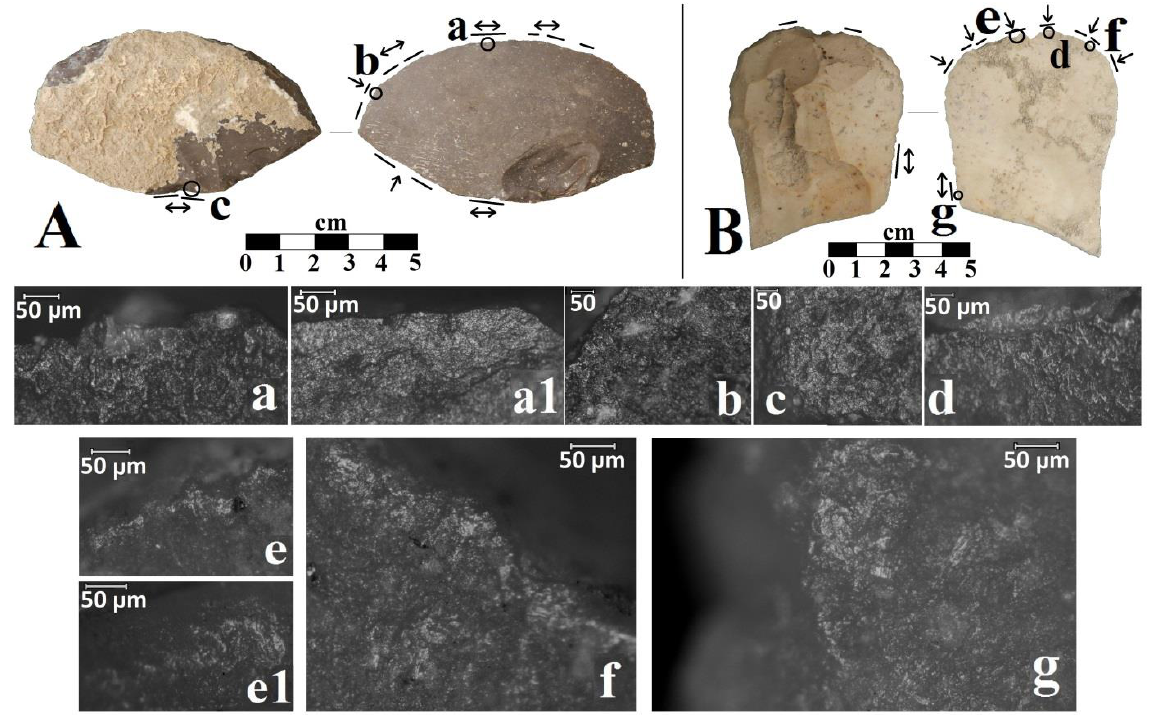
Figure 6. Microwear on Ein Zippori fan scrapers ( A , B ) and experimental deer butchering and fresh bone scraping tools compared. a : bright bone and rough “greasy” meat or fresh hide polish on distal edge of A . a1 : Bright bone and rough “greasy” meat polish on experimental flint blade used to butcher a deer. e : bright bone polish and short striations along left distal edge of B . e1 : bright bone polish and short striations along edge of experimental flint tool used to scrape fresh deer bone. b , d , f : bright bone and rough “greasy” meat or hide scraping microwear. c , g : bright bone and rough meat or hide cutting wear. A : Dorsal (left) and ventral (right) faces of FCFS fan-shaped scraper (MW#16), Area D, late PN, Locus 2009, Bucket 20113. B . Oval CFS fan scraper fragment (MW#9) Area C, late PN, Locus 1944, Bucket 17825. White lines: extent of usewear, arrows show the orientation of microwear polishes and striations, circles: locations of microphotographs a - g . Photomicrographs 187.5x, scales are 50